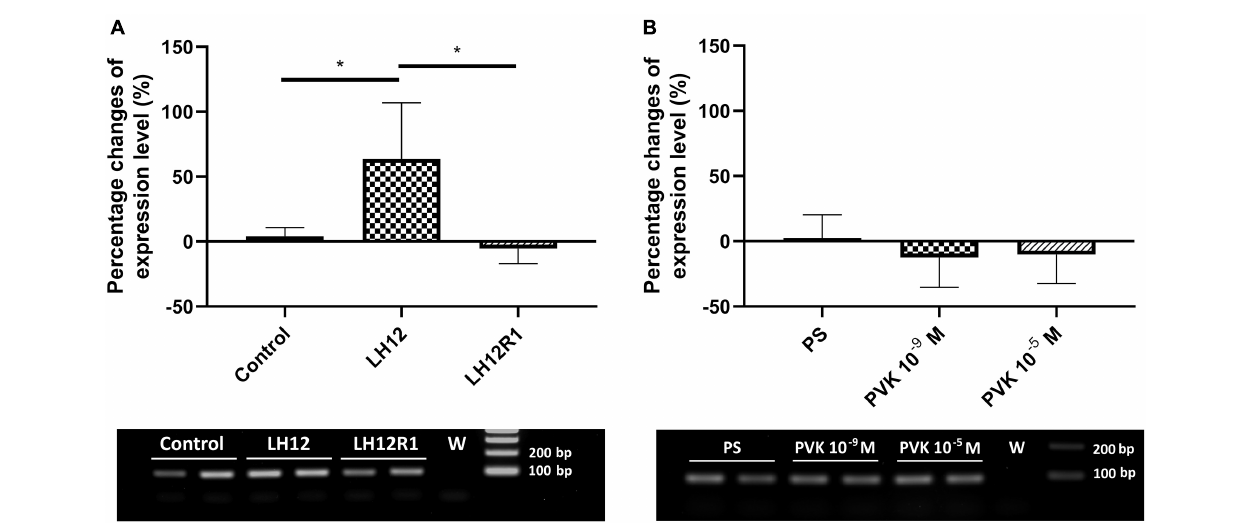
FIGURE 7 | Percent changes in expression of the gene encoding defensin in N. vespilloides after exposure to stressful conditions and after administration of CAPA–PVK neuropeptide, compared to control individuals. (A) LH12: beetles exposed to low humidity for 12 h and LH12R1: beetles exposed to low humidity and recovered for 1 h; PVK 10 − 9 M and PVK 10 − 5 M: beetles analyzed 1 h after injection of Tenmo–PVK-2 at concentrations of 10 − 9 and 10 − 5 M (B) . Below are exemplary results of the semiquantitative RT-PCR analyses. The data presented as mean ± SEM, * p ≤